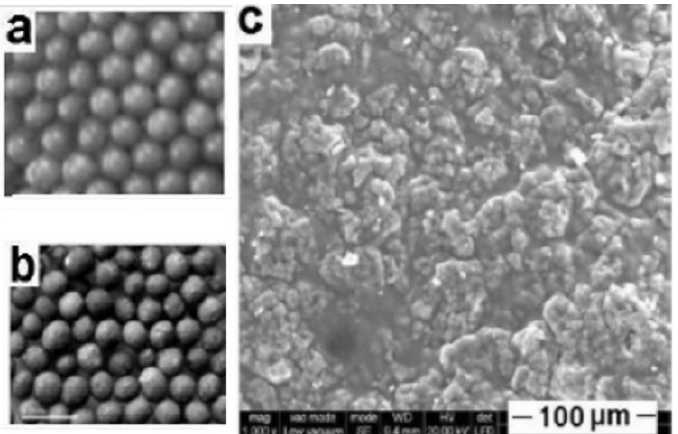
Figure 1. Photographic and SEM images of the catalyst beads; a). Photographic images of wet beads; b). Photographic images of calcined beads; c). Scanning electron micrograph image, MF 1000